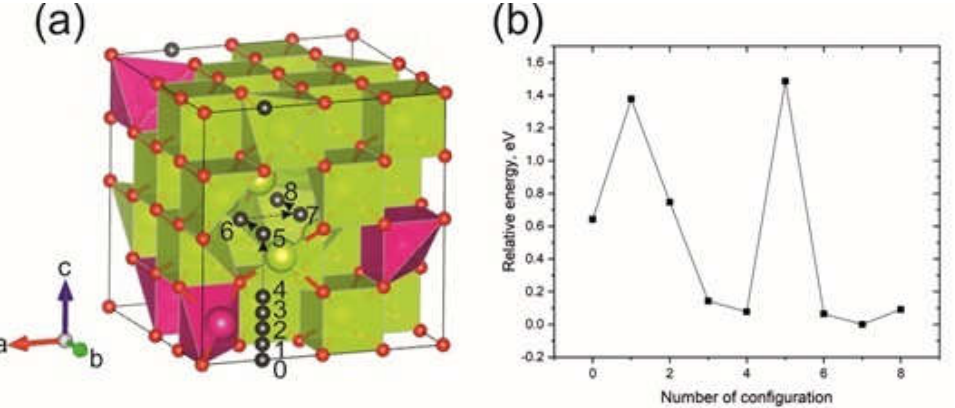
Figure 10. ( a ) The numbers designate different locations that one oxygen anion can occupy with respect to the dopants (grey balls). ( b ) Energy profile along 0–8 path. The light green, pink and red balls represent Ce, Sm and O atoms, respectively.